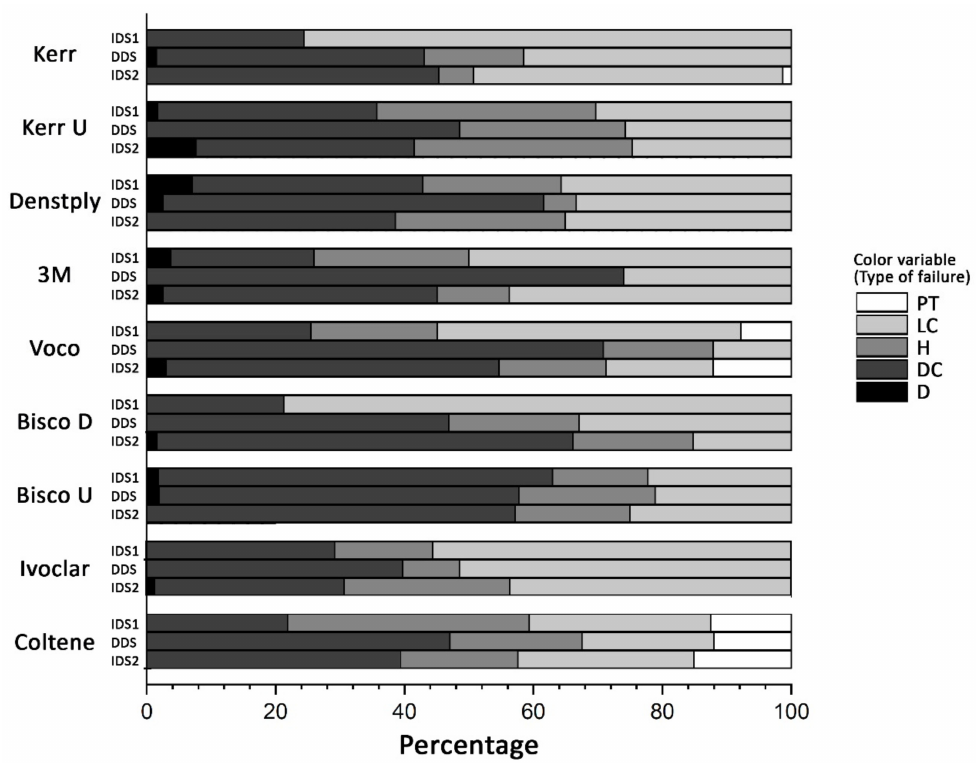
Figure 2. Failure mode analysis (percentage). type of failure: pretest (PT), at Lava™ Ultimate/resin